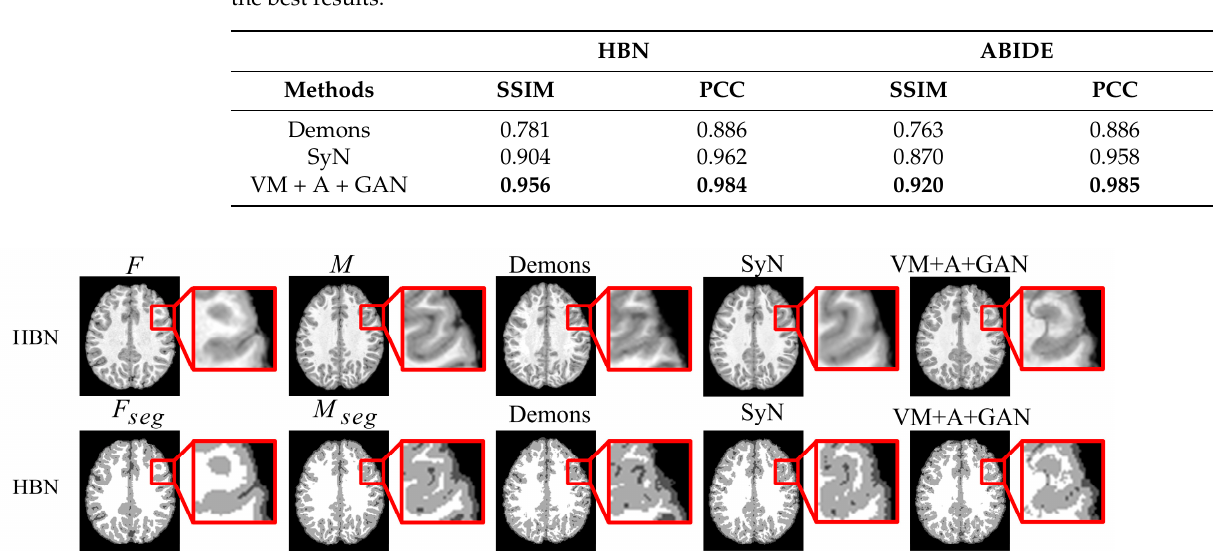
Table 2. SSIM and PCC metrics obtained with the HBN and ABIDE datasets. Bold numbers indicate the best results.